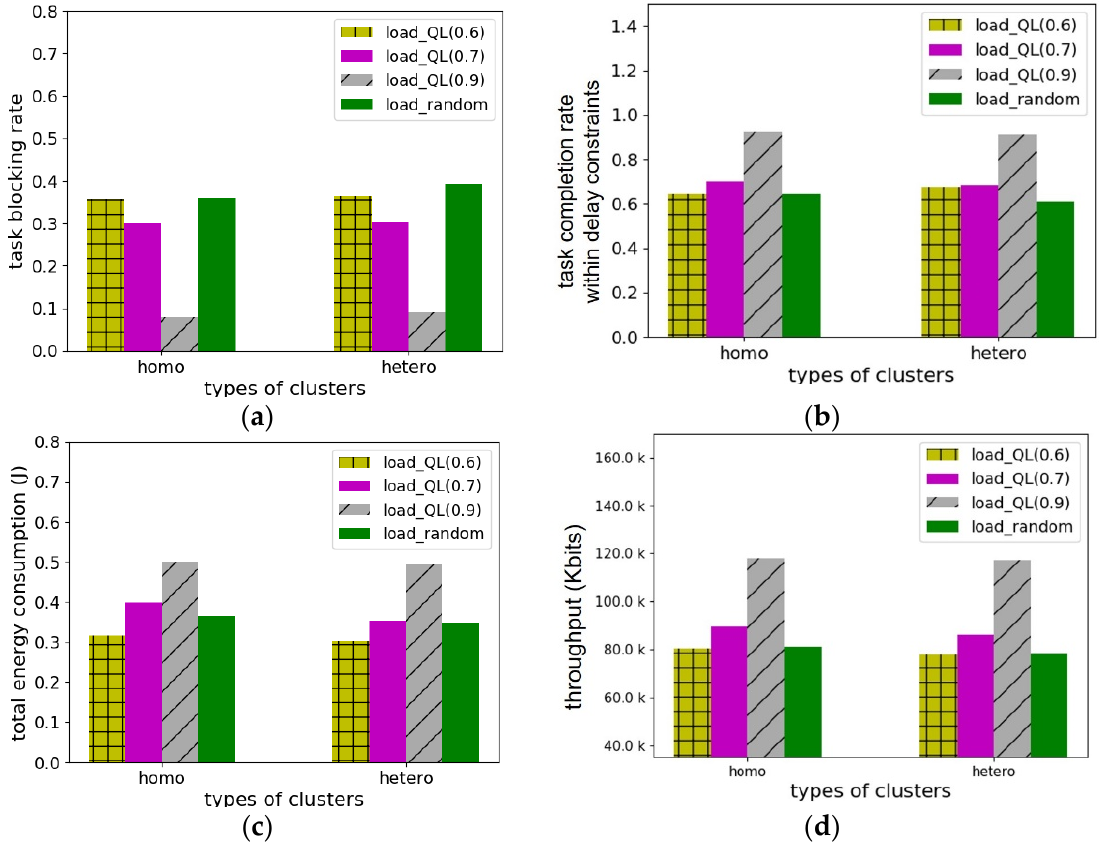
Figure 5. Performance comparison according to cluster types when using same-target MECS and D2D device selection methods with the different optimal offloading strategy (the number of devices is 52 and task arrival rate is 0.8): ( a ) task blocking rate; ( b ) task completion rate within delay constraints; ( c ) total energy consumption( J ); ( d ) throughput.